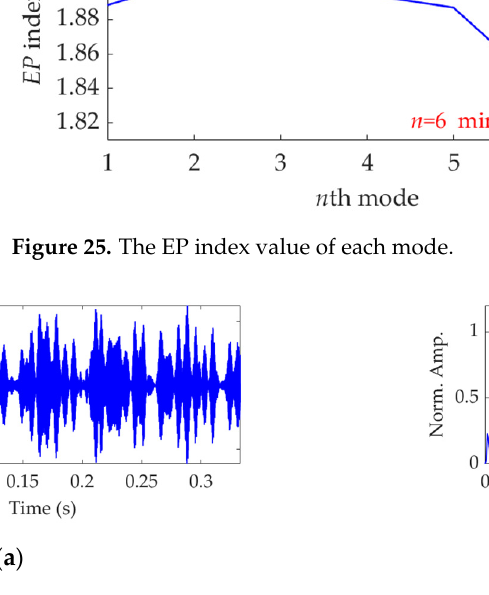
( b ) Figure 27. The target mode obtained by VMD: ( a ) time − domain waveform and ( b ) SES. 7. Conclusions In this paper, we propose a rolling bearing fault diagnosis method based on SVMD and the EP index. As there is only the balancing parameter needing to be optimized for SVMD, the SVMD method is more feasible to implement than the VMD method, which needs to optimize the number of modes and balancing parameter simultaneously. Nev- ertheless, it is not easy to determine the optimal value of the balancing parameter for